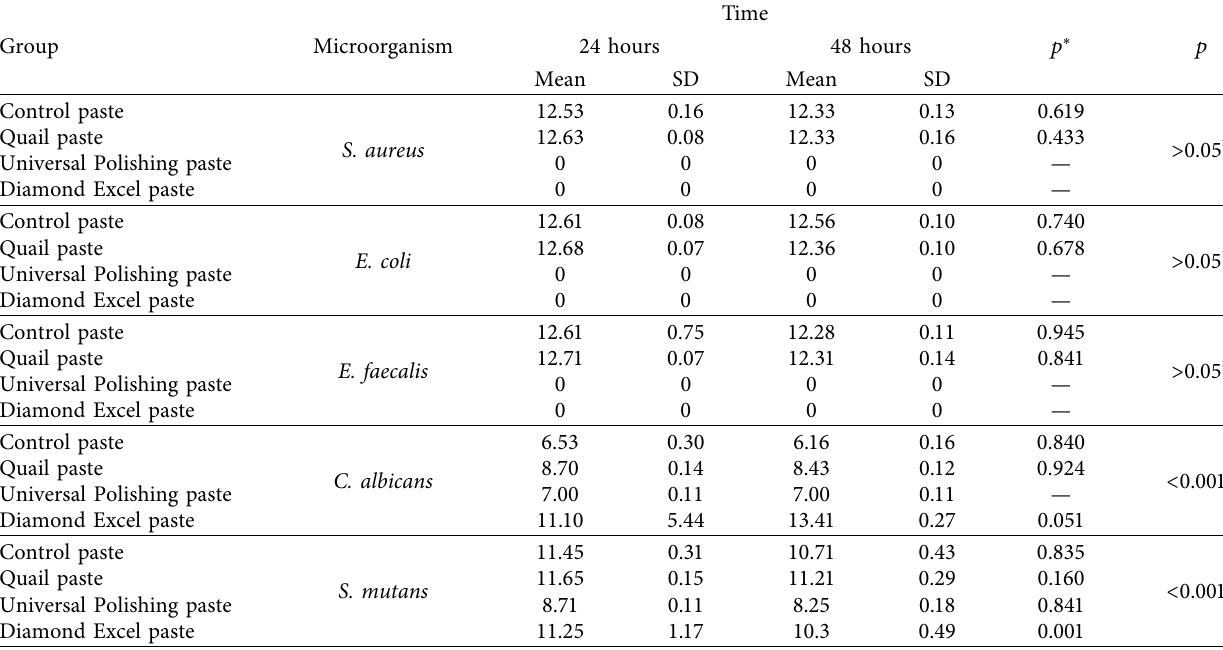
Table 2: Comparison of the antimicrobial efficacy of quail paste versus others according to time and type of microorganism.